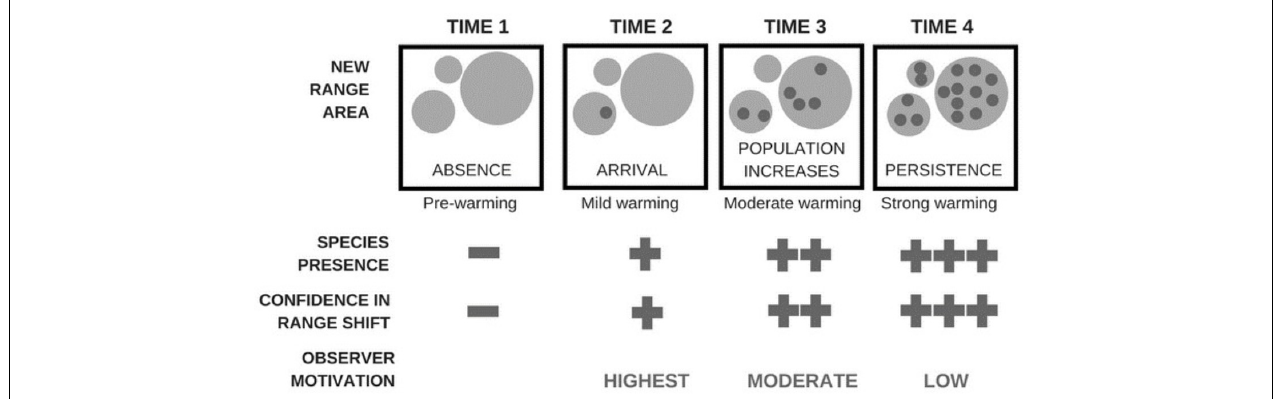
FIGURE 1 | The stages of a species geographic range extension, with gray circles representing possible suitable habitats and black circles individuals of a given species (adapted from Bates et al., 2014). Out-of-range observations are associated with longer-term climatic features (Fogarty et al., 2017), i.e., they likely represent the ‘arrival’ stage of a range extension and it is these individuals that the Redmap project is designed to detect. When species presence is low at a given location, citizen scientists are motivated to report species occurrences, however, this motivation declines after it becomes more widely known and accepted that a species now occurs in a particular area. Confidence that a range shift has occurred increases over time, as individuals of a species persist and continue to be recorded within a given